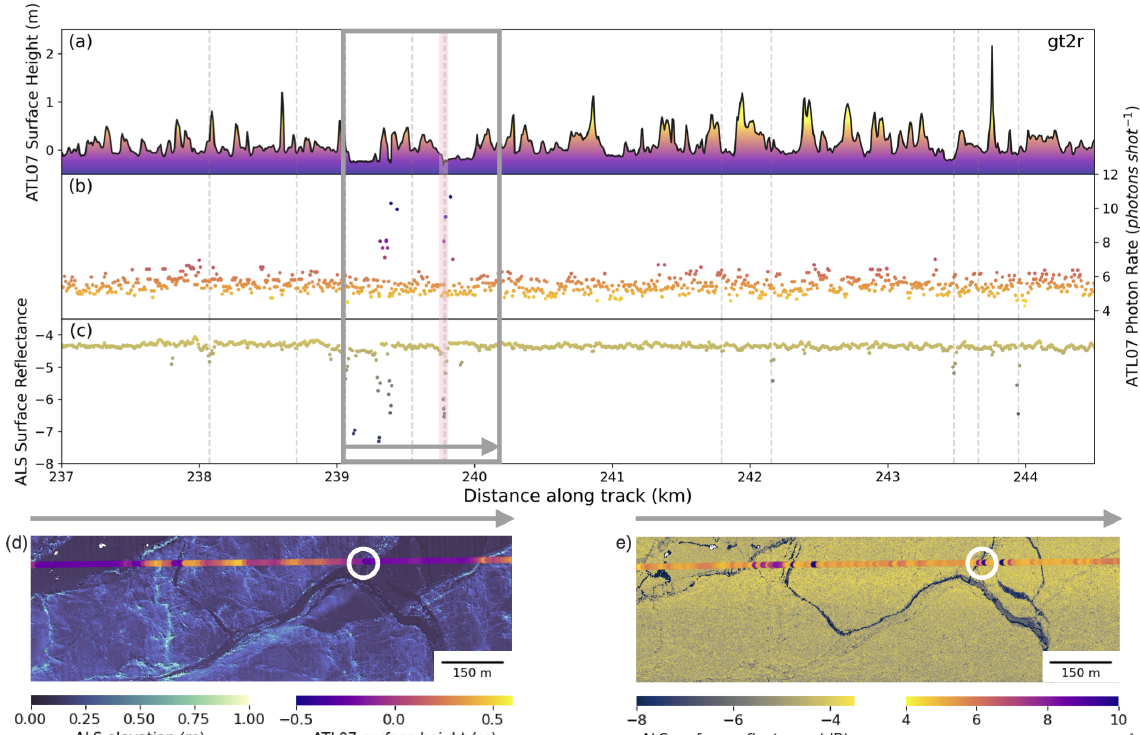
Figure 8. A ≥ 7km section of the overlapping flight path with leads detected from ATL07 gt2r (vertical pink line) and from the ALS (vertical dashed gray lines). The three line profiles show the ATL07 height profile colored by elevation (a) , ATL07 photon rates (b) , and ALS surface reflectance (c) . In panels (b) and (c) , darker points represent values more probable to be classified as leads. The gray outlined box indicates the length of the subsections showing the gridded ALS elevations and coincident ATL07 gt2r elevations (d) as well as the gridded ALS surface reflectance and coincident ATL07 photon rates (e) . The gray arrow indicates the flight direction. White circles highlight the only registered lead in